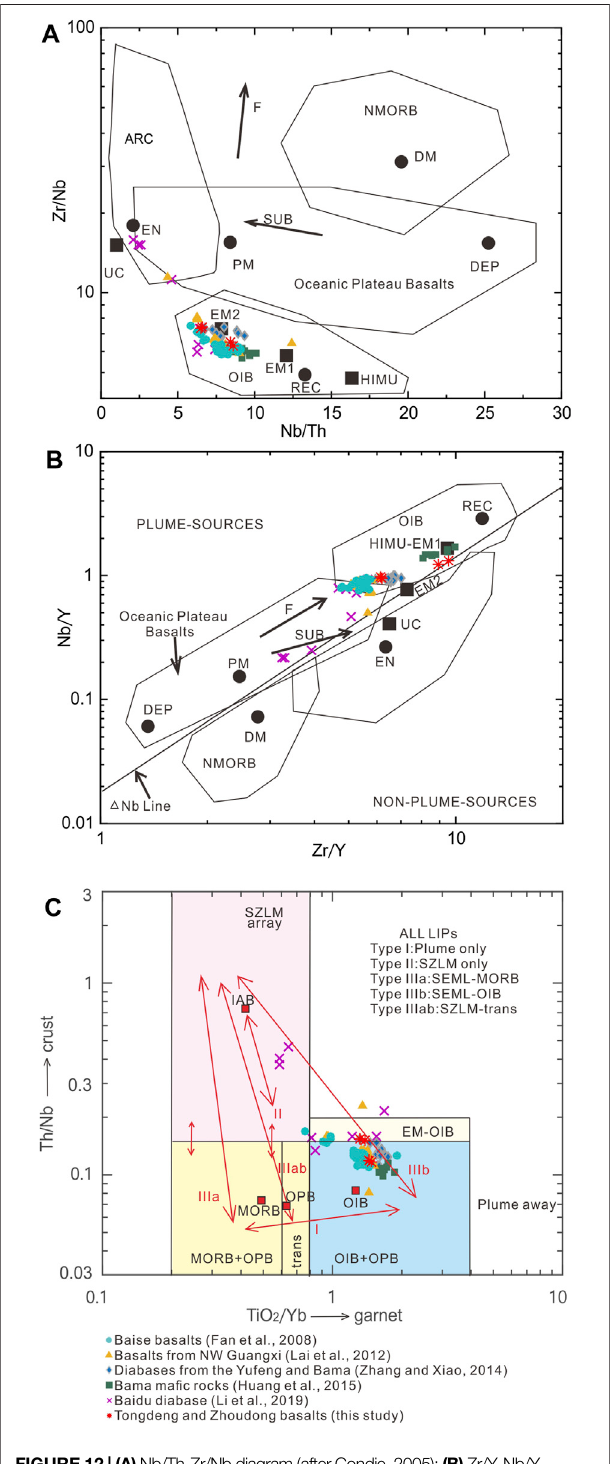
FIGURE 12 | (A) Nb/Th-Zr/Nbdiagram(afterCondie,2005); (B) Zr/Y-Nb/Y diagram (after Condie, 2005); (C) TiO2/Yb-Th/Nb diagram (after Pearce et al., 2021). UC – upper continental crust; PM – primitive mantle; DM – shallow depleted mantle; HIMU – high mu (U/Pb) source; EM1 and EM2 — enriched mantle sources; ARC – arc related basalts; NMORB – normal ocean ridge basalt; OIB – oceanicislandbasalt;DEP – deepdepletedmantle;EN – enrichedcomponent; REC – recycled component; OPB – oceanic plateau basalt; IAB – island arc